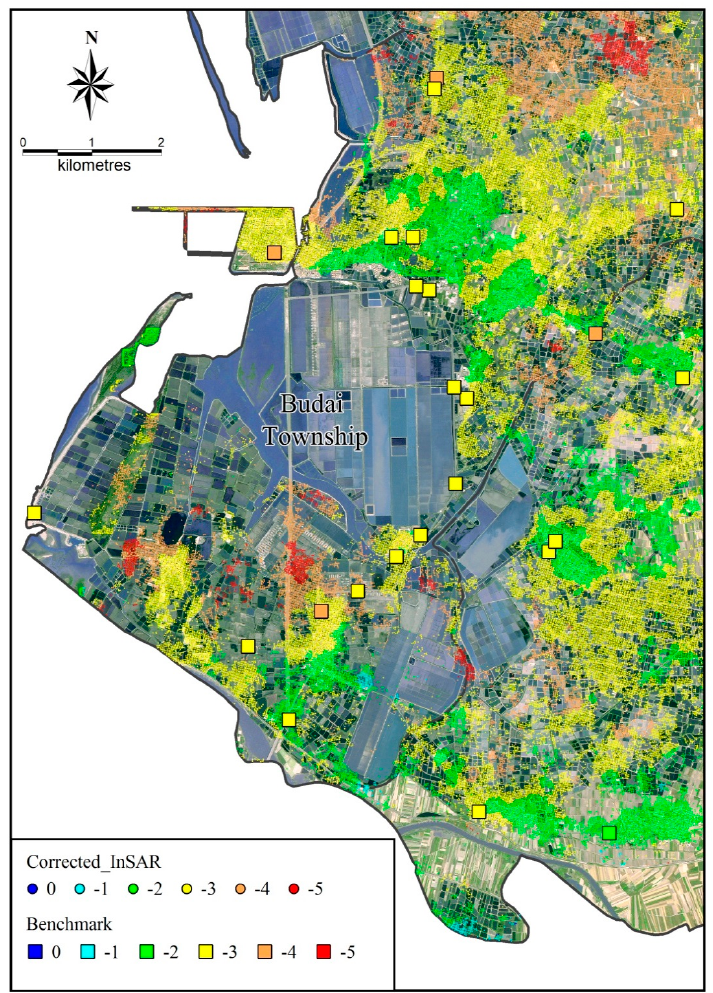
Figure 14. Vertical rates at TCPS from the corrected InSAR (LOS rates projected in the vertical direction) and at leveling benchmarks around Budai. Leveling benchmarks are located along main roads, while TCPs are over any qualified spots as reflectors.